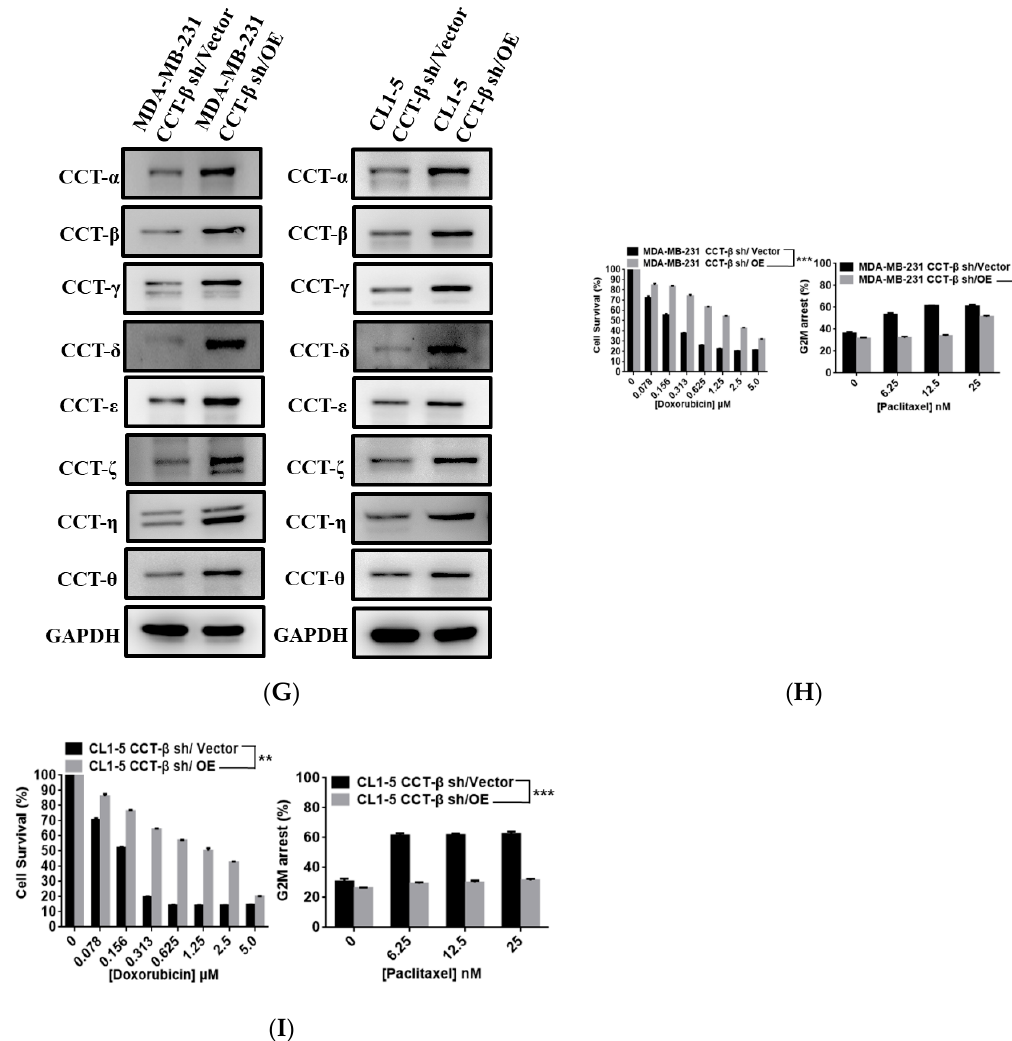
Figure 2. Correlation of drug sensitivity/resistance with CCT- β expression. ( A ) Western blot analysis of the CCT- β expression levels in various breast cancer and lung cancer cell lines. ( B ) The lower expression levels of CCT- β in the MDA-MB-231 and CL1-5 cells after siRNA treatment. ( C ) Western blot analysis of all the CCT subunits in the MDA-MB-231 and CL1-5 cells transfected with the CCT- β siRNAs. ( D ) The apoptotic levels of the MDA-MB-231 cells with and without CCT- β knockdown after doxorubicin and paclitaxel treatments assessed by MTT assays and flow cytometry analysis, respectively. The data showed that the CCT- β -knocked down cells became more sensitive to the anticancer drugs. ( E ) The apoptotic levels of the CL1-5 and CCT- β -silenced cells after doxorubicin and paclitaxel treatments assessed by MTT assays and flow cytometry analysis, respectively. ( F ) The higher expression levels of CCT- β resulted from overexpression of CCT- β in the CCT- β -silenced cells. ( G ) Western blot analysis of all the CCT subunits in the MDA-MB-231 and CL1-5 cells with overexpressed CCT- β from the CCT- β -silenced cells. ( H ) Overexpression of CCT- β in the CCT- β -silenced MDA-MB-231 cells recovered resistance. ( I ) Overexpression of CCT- β in the CCT- β knockdown CL1-5 cells recovered resistance. Data are presented as the mean ± S.D. of three independent experiments. *** p < 0.001, ** p < 0.01, * p < 0.05 vs. the control. Our data indicated that the CCT- β expression level correlated with the drug sensitivity / resistance of cancer